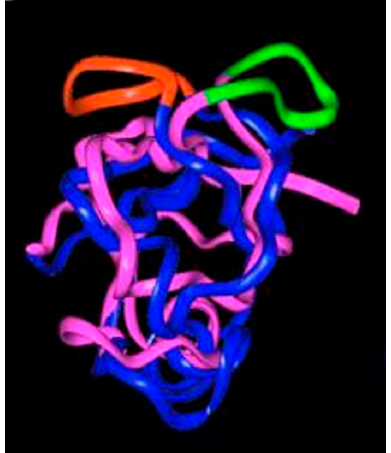
Figure 3. Ribbon representation of the superimposed average molecular dynamics RAF RBD structures bound to oncogenic (Val 12-) RAS-p21 (blue and red structure) and to wild-type RAS-p21 (pink and green). The exposed loop on the top surface of the figure of the 97–110 segment is colored green in the wild-type complex and red in the oncogenic complex (adapted from [15]).